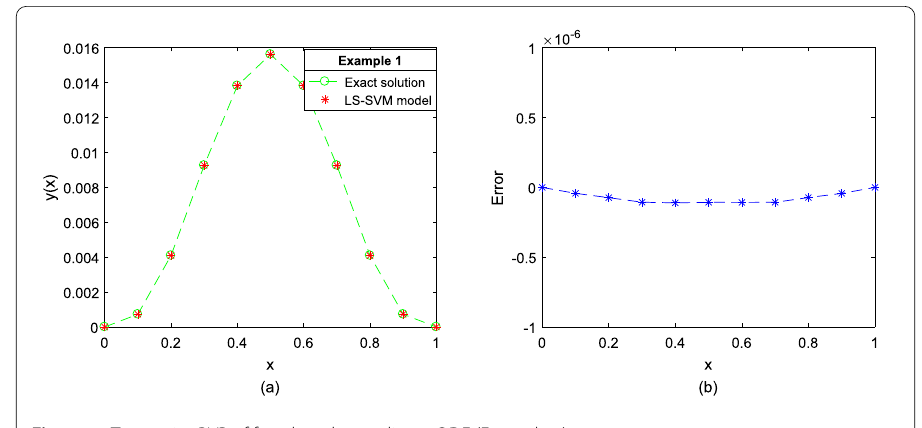
Figure 1 Two-point BVP of fourth-order nonlinear ODE (Example 1)